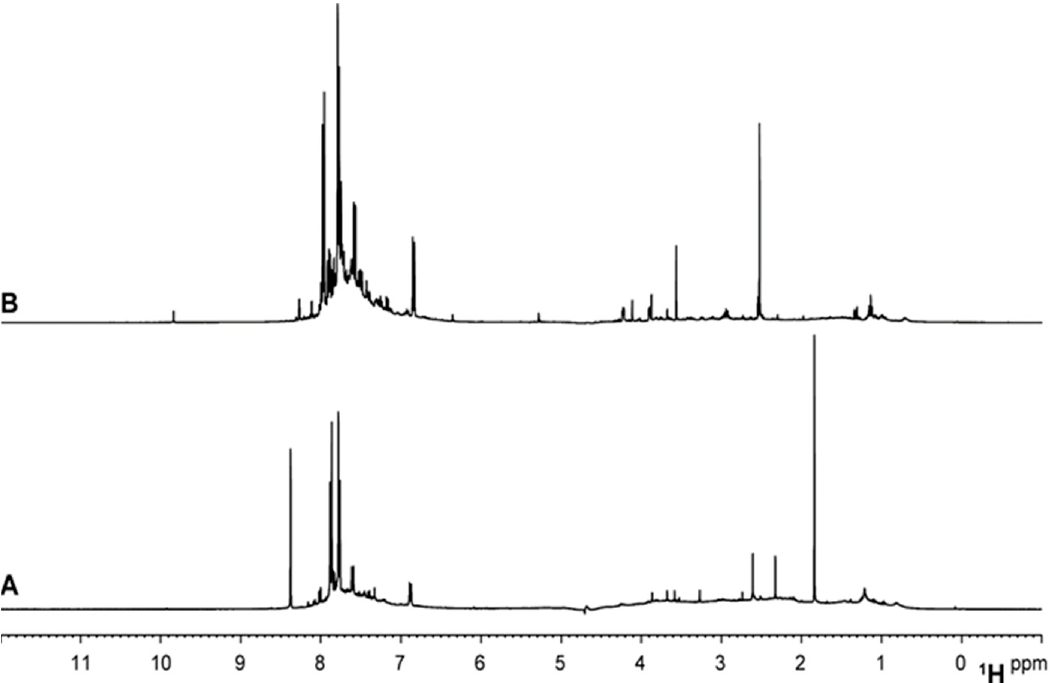
Figure 4. 1 H NMR spectra of FA samples extracted from soil ( A ) and water ( B ).